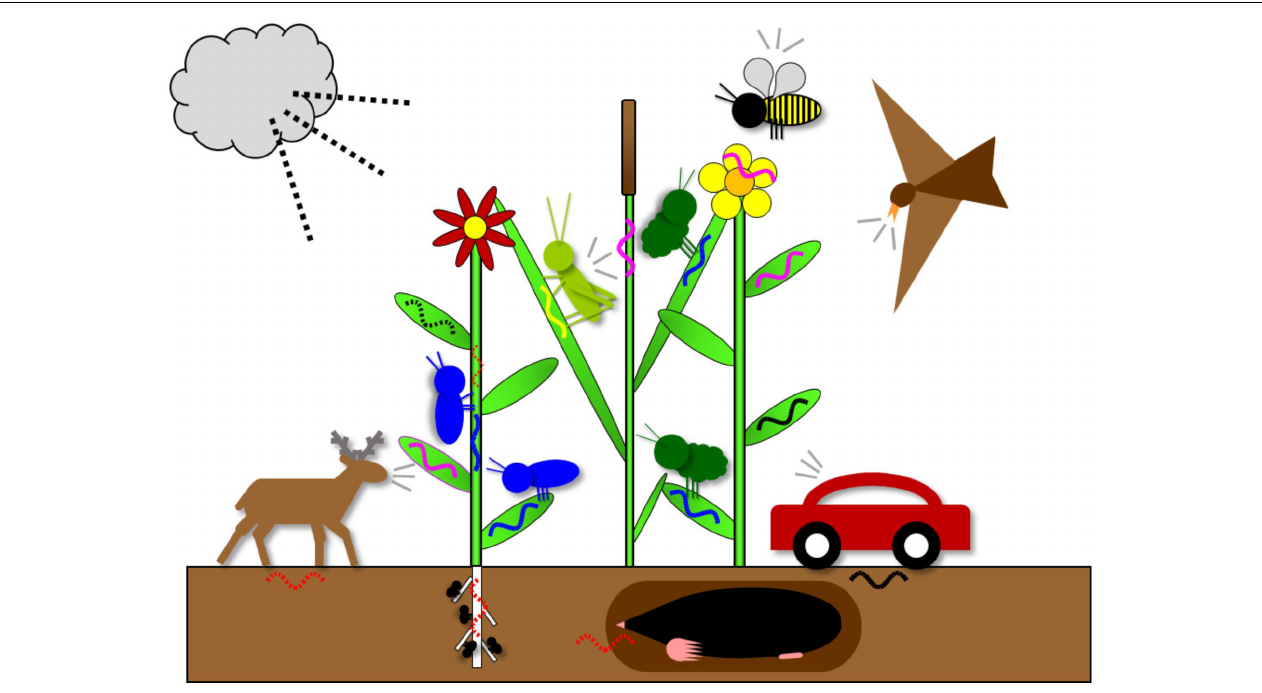
FIGURE 1 | Schematic presentation of sources that can contribute to a vibroscape recorded in a hay meadow habitat. The main source of biological vibrations are vibrations emitted by animals, either during intraspecific vibrational communication (blue waves), or as an incidental by-product of other activities [red dotted waves, vibrations induced by locomotion (walking deer, digging mole, walking insect) and feeding (insect nymphs on the roots)]. Biological component also includes directly (yellow wave, stridulating grasshopper) or indirectly induced vibrational components of air- borne animal sounds (pink waves: stridulating grasshopper, singing bird, calling deer, wing buzzing bee). The main source of geophysical vibrations is wind (black dotted wave). Anthropogenic vibrations (directly and indirectly induced) (black waves) are represented by a car. Other sources not shown (e.g., animals communicating with vibrational signals underground, landing of insects on the plant, rain) also contribute to